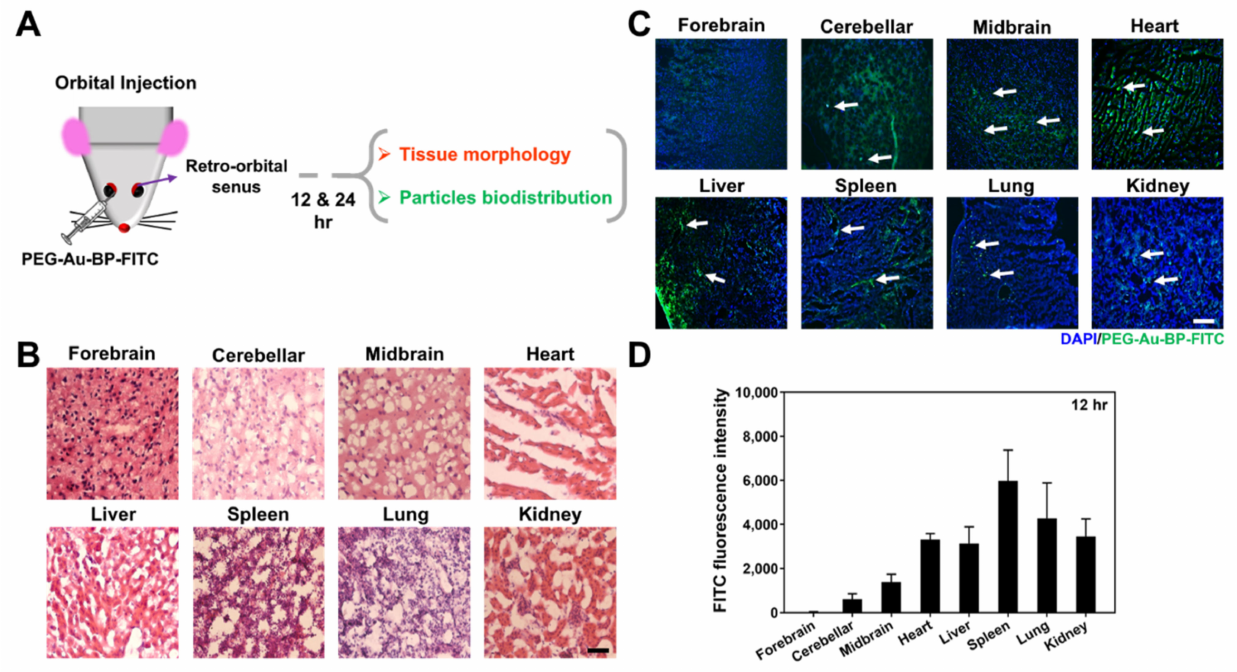
Figure 9. Tissue morphology and particle distribution after PEG-Au-BP treatment for 12 h in an animal model. ( A ) The illustration indicated the mice were injected with PEG-Au-BP nanoparticles through retro-orbital sinus injection. ( B ) Each tissue was stained with H&E staining to observe the tissue integrity after the treatment. The images indicated that the organs would not be harmed by PEG-Au-BP. ( C ) The histological images demonstrated the particle distribution in each organ. The white arrows demonstrate the FITC labeled PEG-Au-BP nanoparticles (green color). Cell nuclei were stained by DAPI solution (blue color). Scale bar equals to 50 um. ( D ) The FITC fluorescence intensity of PEG-Au-BP in each organ was quantified, where the nanoparticles could also be observed in brain tissue, indicating PEG-Au-BP could stay in brain tissue for anti-cancer